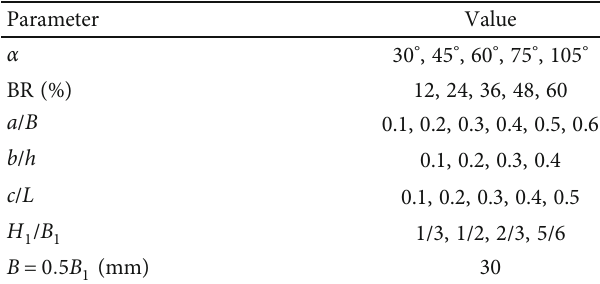
Table 2: Value of structure